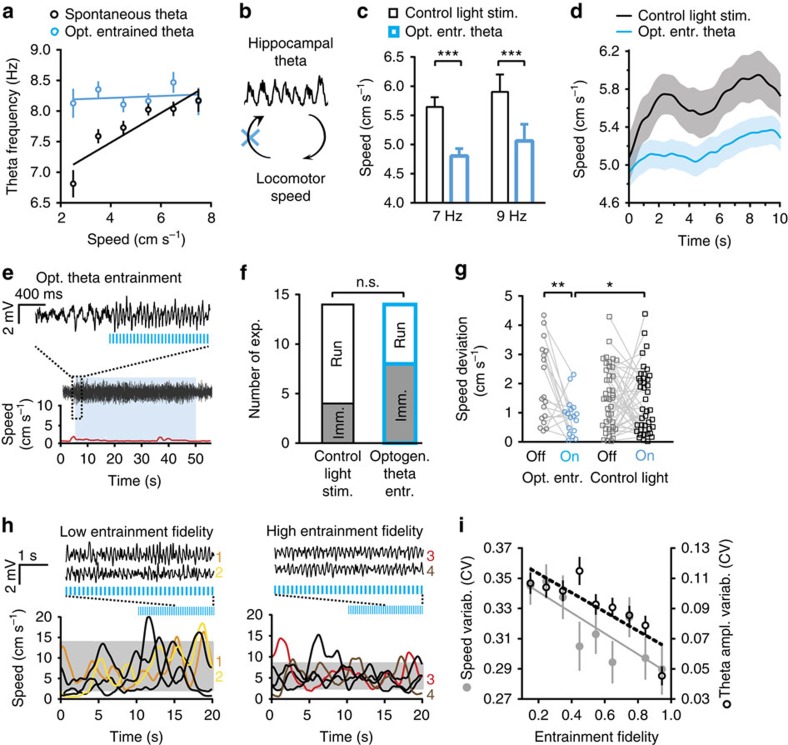
Optogenetic entrainment of hippocampal theta oscillations regulates locomotion speed and speed variability.(a) Correlation of running speed and frequency of theta oscillations during spontaneous (r=0.82, Pearson's correlation, P=0.013, N=6 mice, n=42 recording sessions) but not optogenetically entrained theta oscillations (r=0.04, P=0.7, N=8 mice, n=72 recording sessions). (b) Scheme illustrating a bidirectional influence between theta and locomotion as proposed earlier4810. Optogenetic control of theta removes the influence of speed-correlated afferents on oscillation frequency (blue cross), as oscillation frequency is controlled by the laser pulse frequency. (c) Optogenetic entrainment of theta oscillations at 7 Hz (P=0.0002, Bonferroni test, N=5 mice) or 9 Hz (P=0.0002, N=3 mice) reduced speed in running mice. (d) Running speed during 10-s epochs of optogenetically entrained (blue) and spontaneous (black) theta oscillations. (e) Example of optogenetically elicited theta oscillations during immobility. Hippocampal LFP signal traces (2–250 Hz band-pass filtered, middle), recorded simultaneously with running speed measurement (red trace, bottom). Blue shade marks time of optostimulation. Excerpt, top: LFP signal trace shown at a higher time resolution. (f) Number of experiments when resting mice stayed immobile (Imm.) or moved (Run) during 15 s after stimulation onset (P=0.13, χ2-test, N=8 mice, optogenetic entrainment; N=5 mice, control light stimulation). (g) Speed (deviation from group mean) averaged for 20 s before and after the onset of optogenetic theta entrainment (left, N=8 mice) or control light stimulation (right, N=13 mice). Speed was less variable during optogenetic theta entrainment compared with baseline (P=0.0062, Bonferroni test, n=18 recording sessions, N=8 mice) and control light stimulation recordings (P=0.0107, n=42 recording sessions, N=13 mice). (h) Representative traces before and after the onset of stimulation (7 Hz) with a low (<0.3; left) or high (>0.8; right) entrainment fidelity; grey shadows mark 10%–90% ranges of speed distributions during stimulation. (i) Higher entrainment fidelity was associated with lower coefficients of variation of theta amplitude (r=−0.84, P=0.0046) and running speed (r=−0.84, Pearson's correlation, P=0.0051, n=79 recording sessions, N=8 mice). *P<0.05, **P<0.01, ***P<0.001. Data are presented as mean±s.e.m.